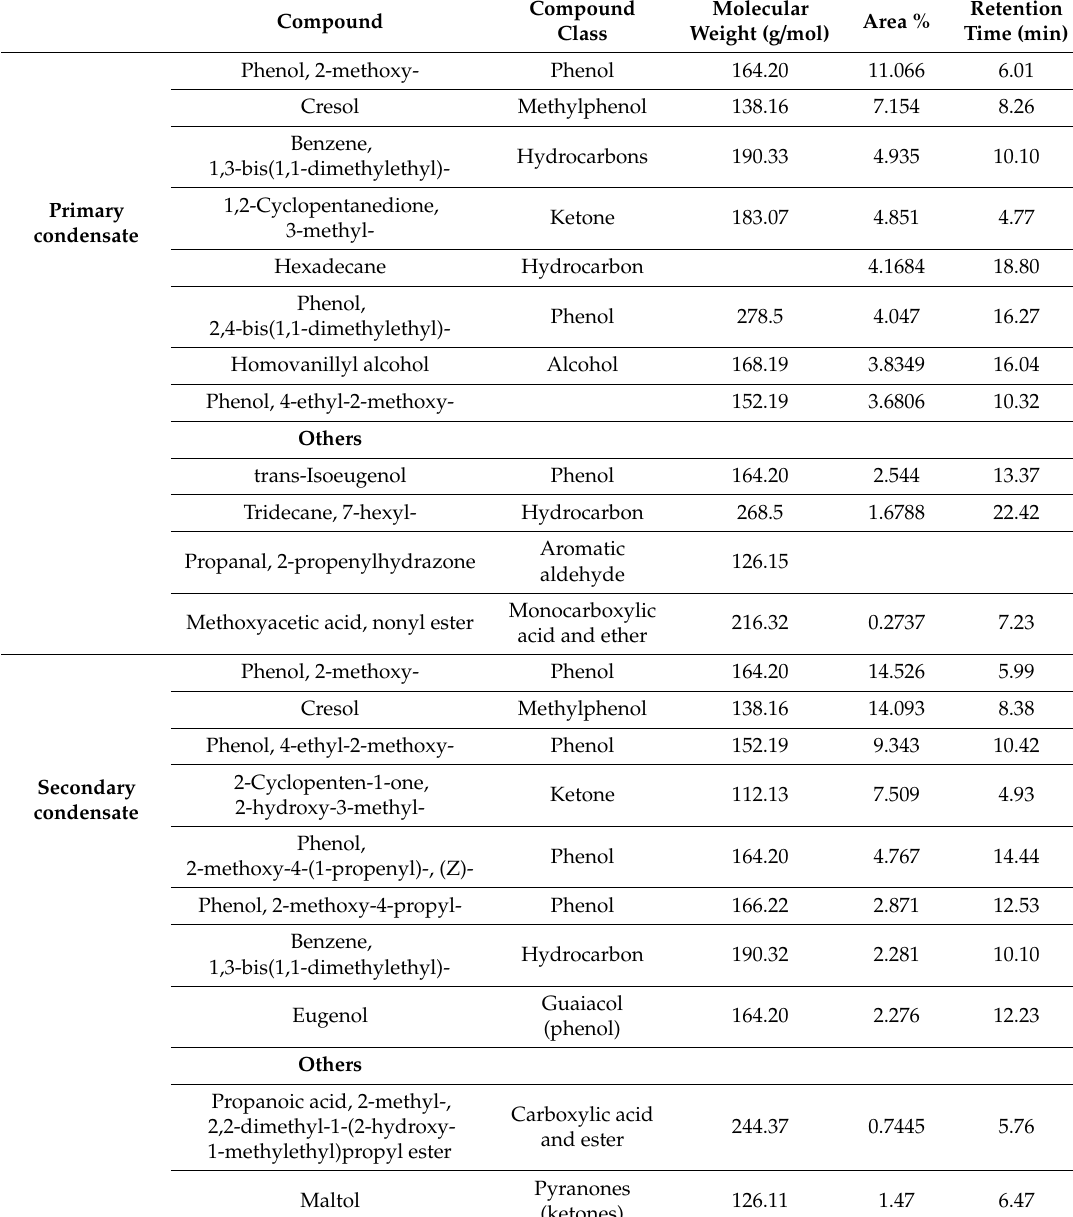
Table 6. GC–MS analysis for pine dust primary and secondary condensates obtained at optimal condition (primary condenser temp of 110 ◦